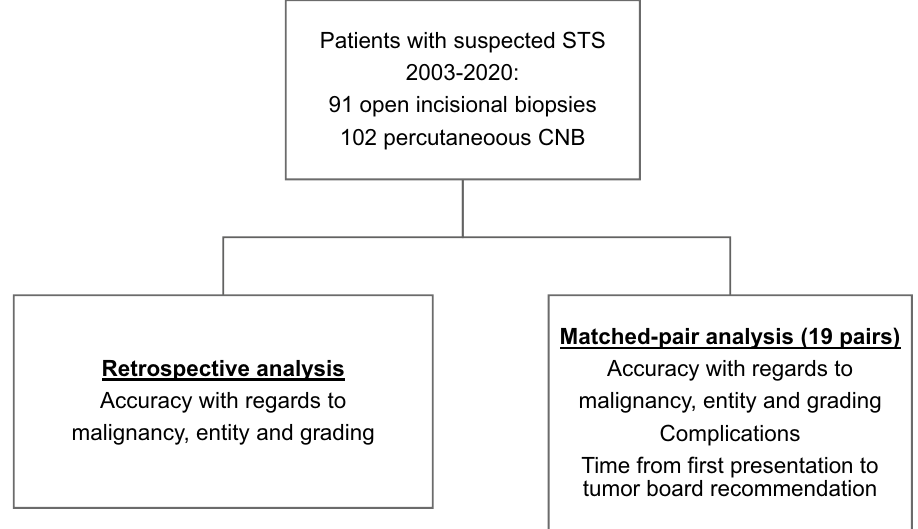
Figure 1. Patients with suspected soft tissue sarcoma (SFT) between 2003 and 2019 were included in the study. The core needle biopsy (CNB) was introduced in our department in July 2015, and since then, 102 patients have been diagnosed with CNB. These were compared to 91 open incisional biopsies regarding accuracy in diagnosing the correct entity and tumor grading. Secondly, a pair-matched analysis was conducted on 19 pairs, matching gender, age, and tumor characteristics: histology, localization, size, depth, and grading. The pairs were compared for sensitivity, specificity, the accuracy of diagnosis, complications, and time to case presentation in the interdisciplinary tumor